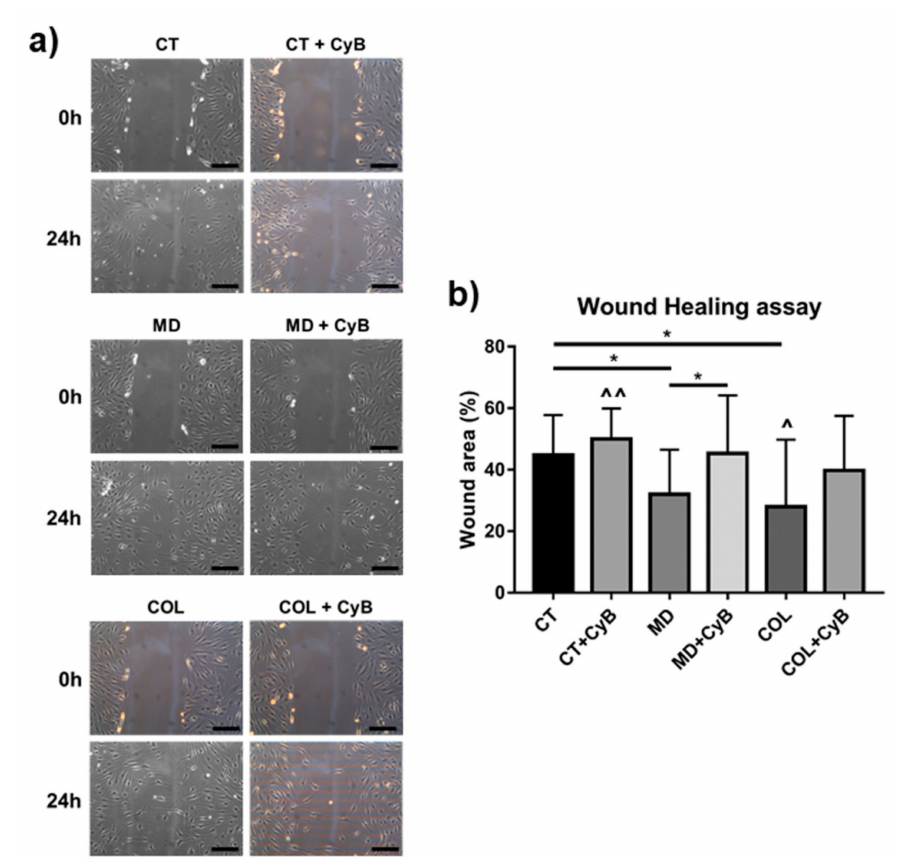
Figure 9. ( a ) Representative phase contrast micrographs showing the results of the wound healing assay in control tenocytes (CT) and tenocytes grown on MD and COL at 0 and 24 h after the scratch, with or without CyB administration. Original magnification: 10 × . ( b ) Bar graphs showing the area of wound closure after 24 h, expressed as a % of the area at 0 h, in cultured tenocytes in the di ff erent experimental conditions. Data are mean ± SD for at least two independent experiments. * p < 0.05 for t -test; ˆ p < 0.05 vs. CT; ˆˆ p < 0.01 vs. MD and COL using